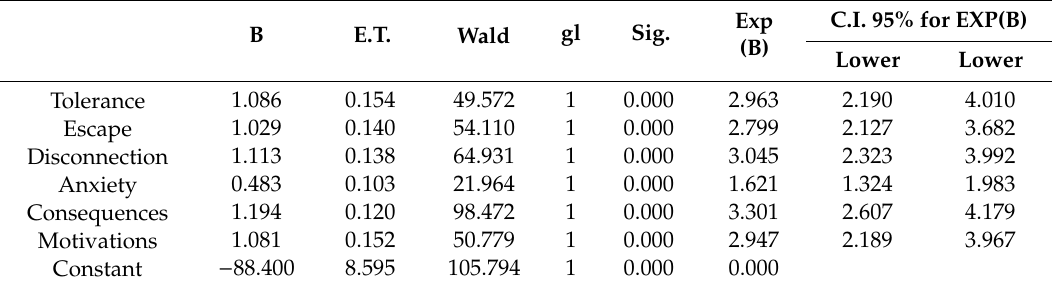
Table 8. Binary logistic regression of the self-perception on the problematic smartphone use a of female university students with respect to the